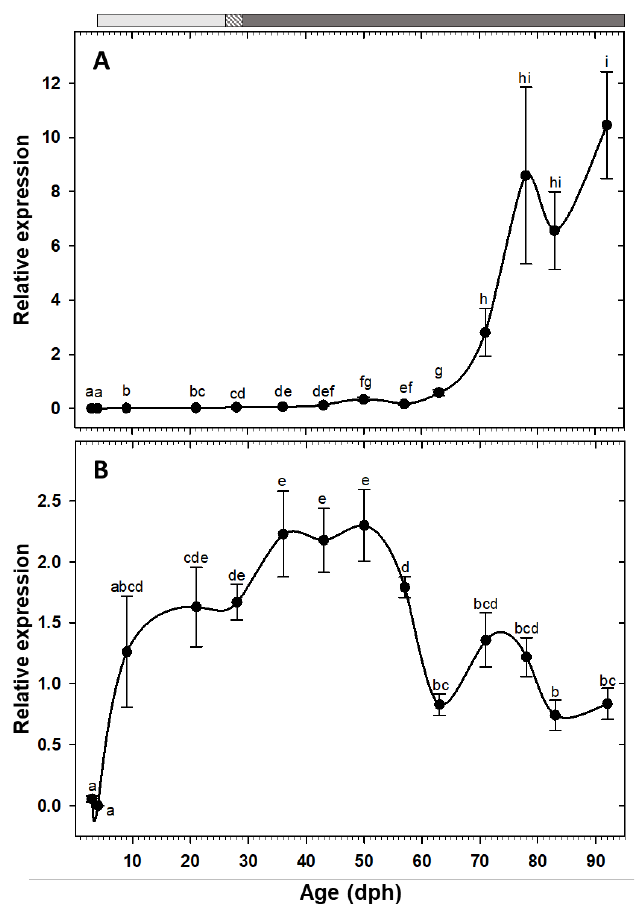
Figure 3. Transcriptional changes of lipases; cel ( A ) and pla2g1b ( B ) in whole-body C. labrosus individuals during development (N = 6 to 10 individuals per sampling point). The rest of legend as in Figure 2.